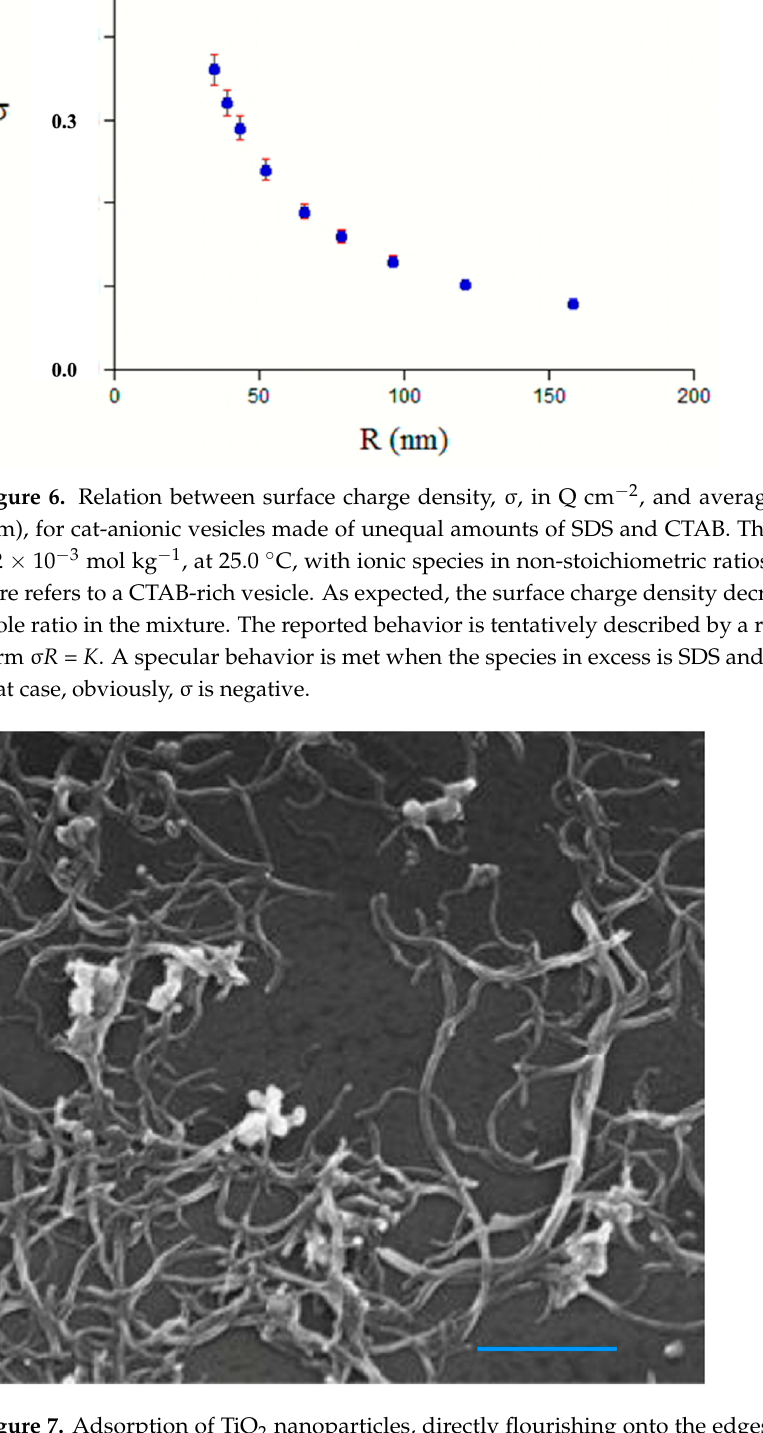
Figure 7. Adsorption of TiO 2 nanoparticles, directly flourishing onto the edges and curvatures of single-strand DNA carbon nanotubes, as flowers do onto the branches of the Judas tree, (Cercis Siliquastrum). The blue bar size length is 250 nm. Redrawn from Reference [83].